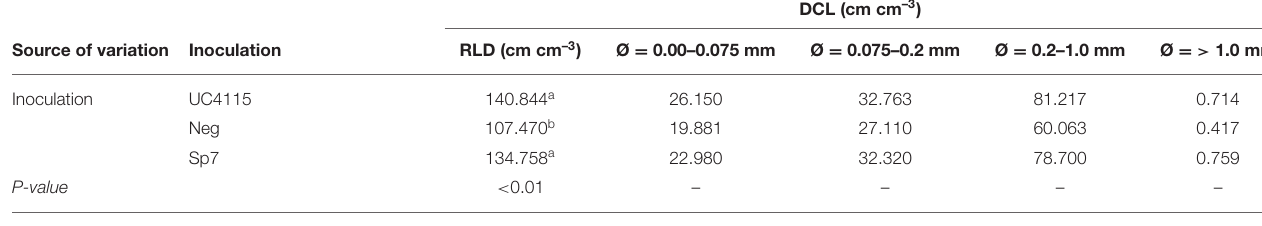
TABLE 5 | Root length density (RLD), and diameter class length (DCL) for very fine (Ø = 0.00–0.075mm), fine (Ø = 0.075–0.2mm), medium (Ø = 0.2–1.0mm), and coarse (Ø = > 1.0mm) diameters for conventional experiment, as affected by inoculation (I) and application (A). Source of variation